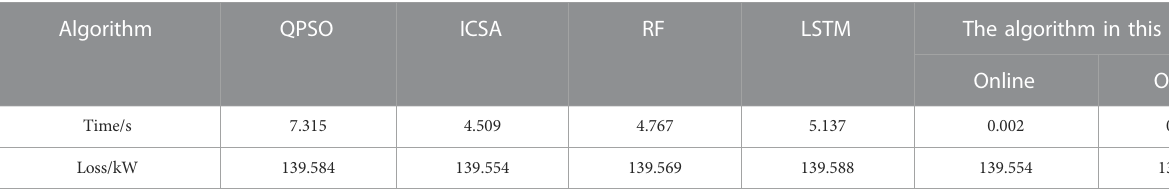
TABLE 6 Comparison of algorithm solution time.